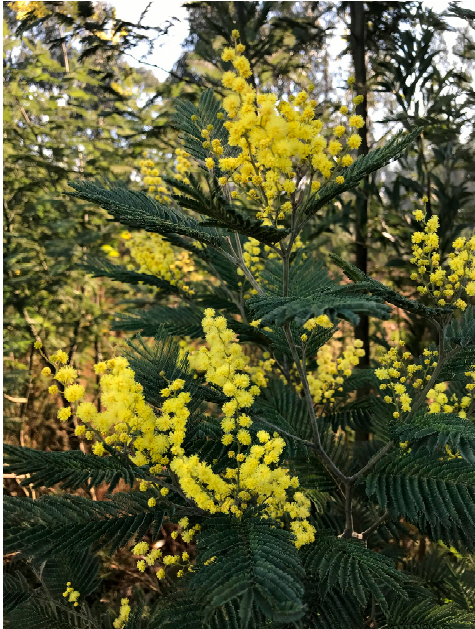
Figure 8. Acacia dealbata flowers.